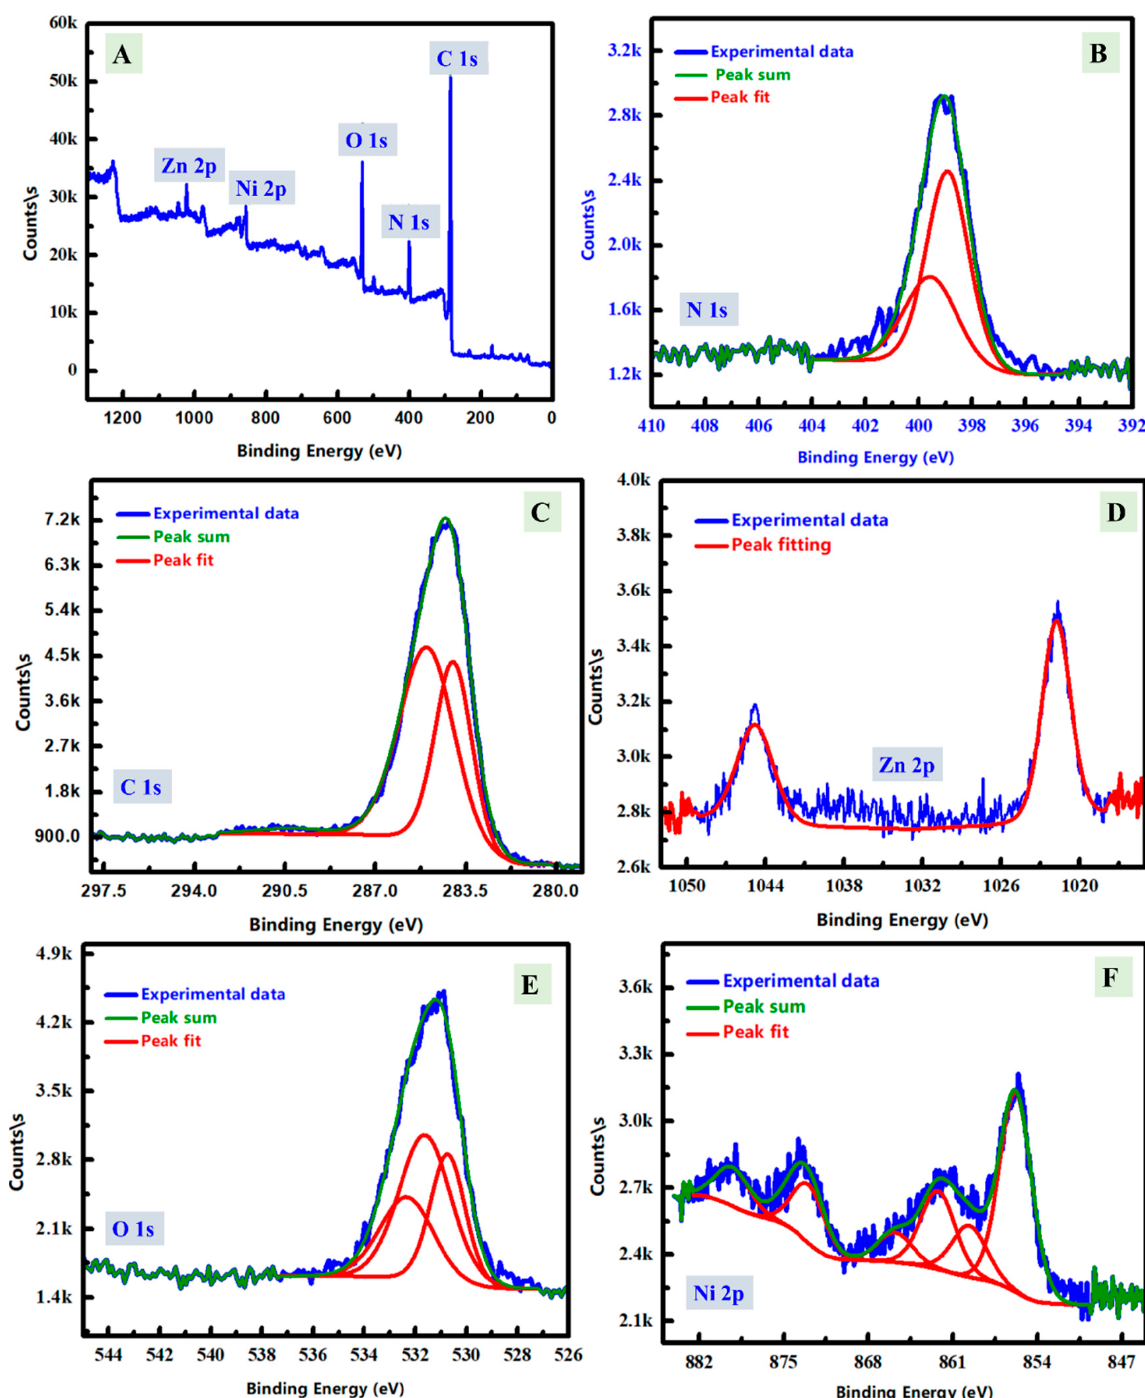
Figure 3. XPS scan analyses of the prepared ZnNiO@PANE composite; ( A ), and the core-level spectra of N 1 s; ( B ), C 1s ( C ), Zn 2p; ( D ), O 1s ( E ), and Ni 2p; ( F ).